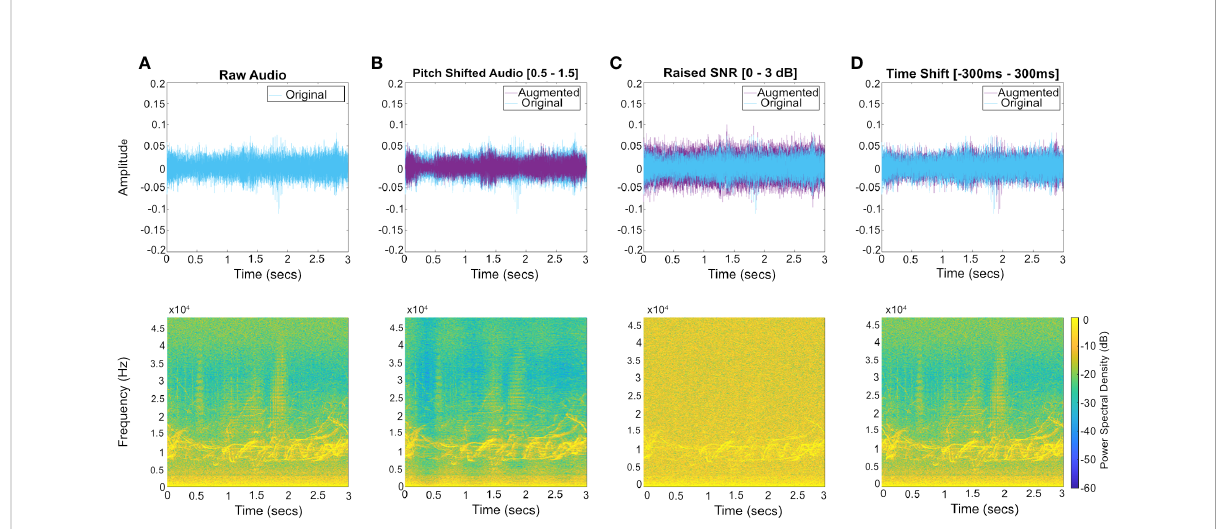
FIGURE 7 Temporal and frequency domain examples of three methods of audio augmentation used to enhance variability within the training dataset. Audio augmentation was performed on raw audio, in the time domain. (A) raw acoustic data; (B) pitch shift applied by a random factor between 0.5 to 1.5; (C) reduction in SNR (up to 3dB); (D) time shift (between -300ms and 300ms). Augmentation maximum and minimum values introduce variance to the training set while maintaining the spectral content within the frame. Each input audio fi le was subjected to two augmentations, the range of augmentation methods and the value parameters for their implementation are randomised. Spectrograms were produced using a Hanning window, FFT size 2048 and a 75% overlap. Augmentation increases the training set three-fold, from 13,198 to 39,594